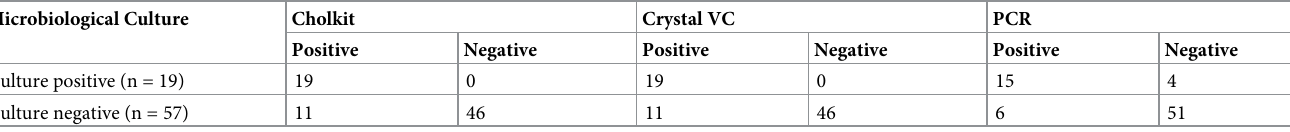
Table 2. Comparison of RDTs with microbiological culture and PCR in 76 study participants in Bangladesh. Microbiological Culture